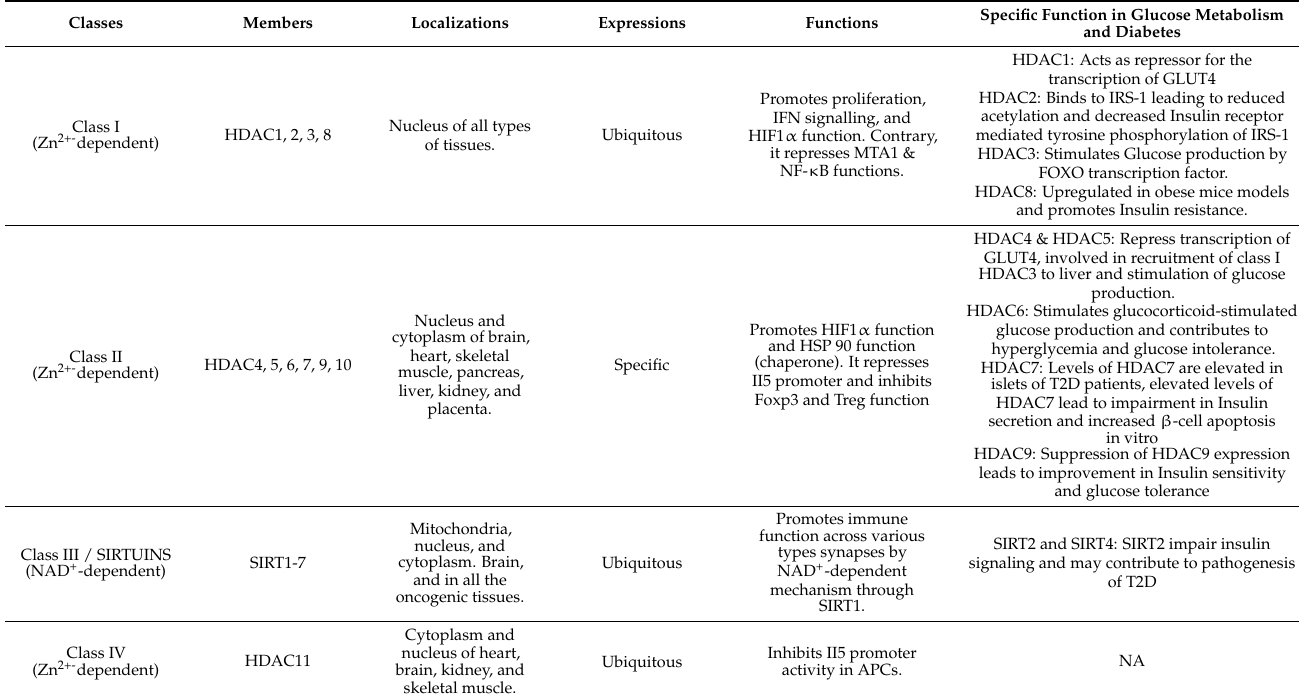
Table 1. Localization, expression, functions of different HDACs. Their specific roles in respective classes and in glucose metabolism and diabetes are also